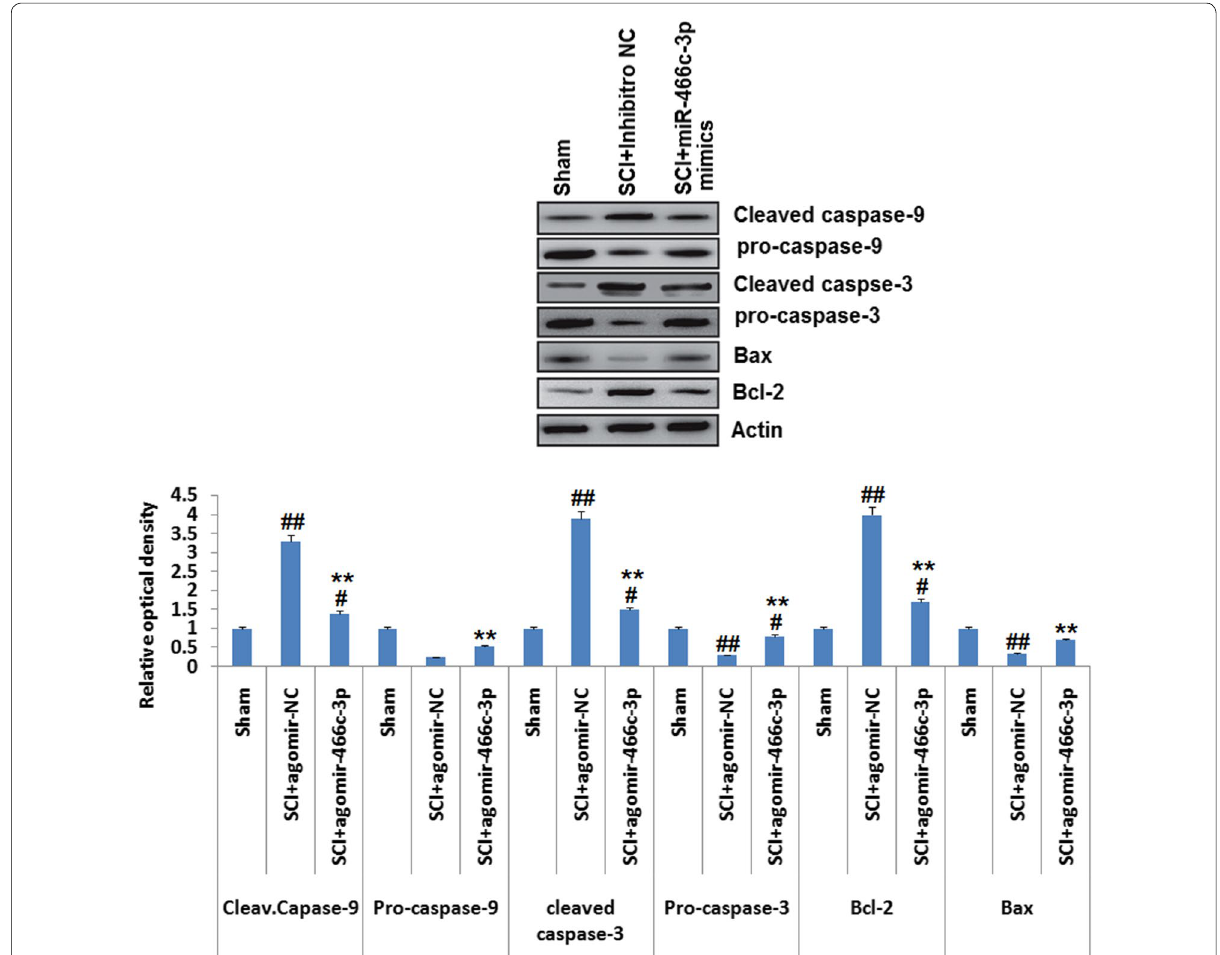
Fig. 5 The experimental animals were induced with spinal cord injury and were exposed to miR-466c-3p mimics or agomir-negative control followed by western blot analysis for determining the expression of cleaved-caspse-9, cleaved-caspase-3, pro-cspase-3, Bcl-2 and Bax in the spinal cord tissue subjected to injury, actin was selected as loading control. The results are mean rats treated with agomir-negative control; #P < 0.05, ##P < 0.01 compared to sham operated +